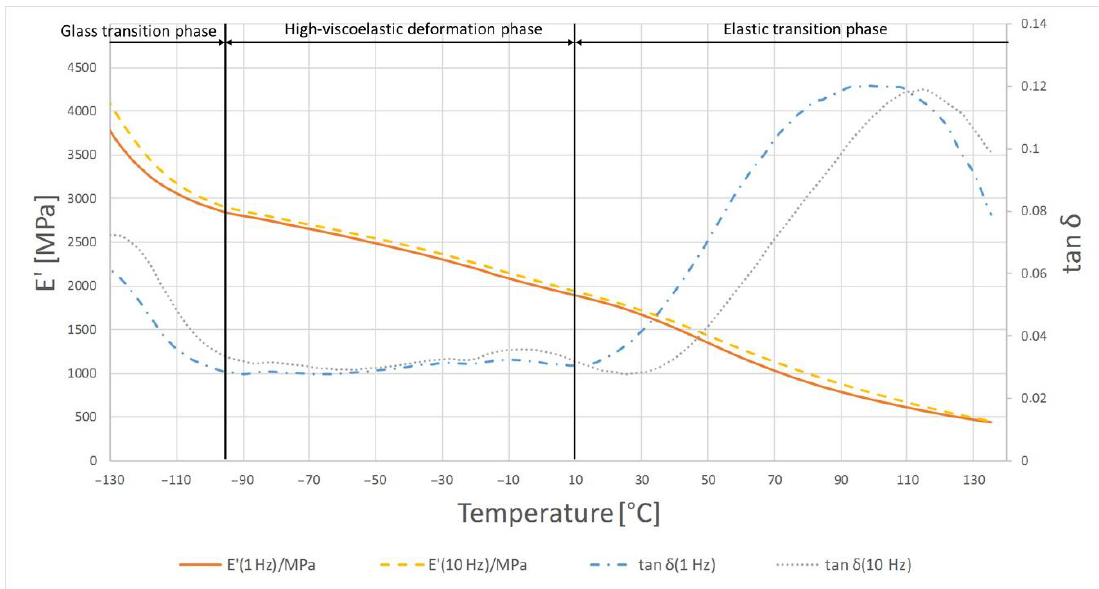
Figure 6. Results of DMTA tests for PE1000.